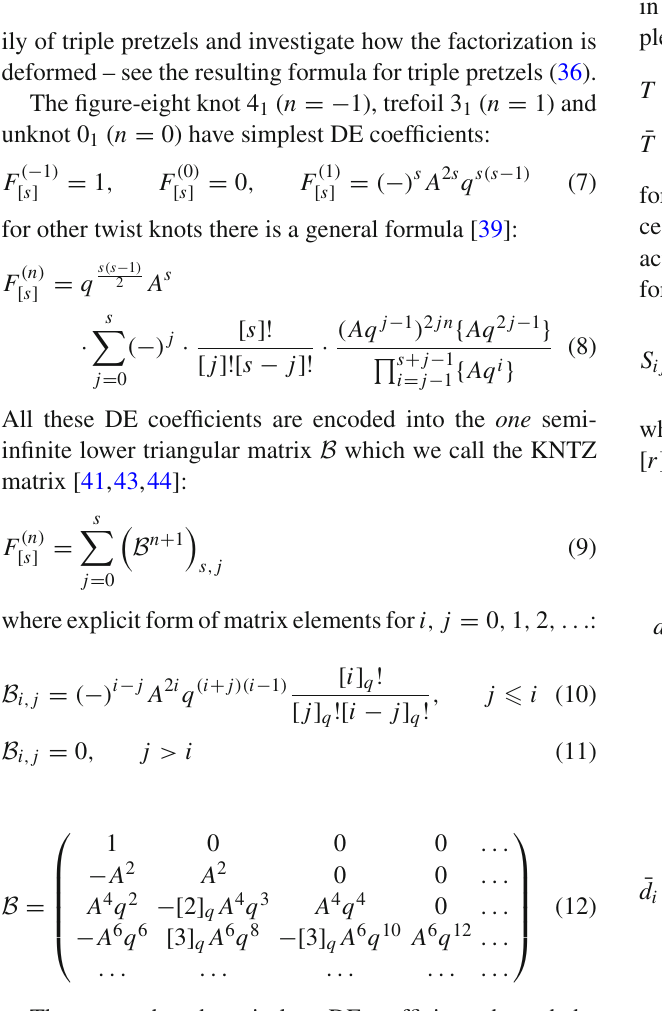
Fig. 2 The pretzel knot Pr ( 7 , 5 , 3 ) that is obtained after several steps of antiparallel evolution from the trefoil knot. Indeed, one can see that the crossings of the trefoil knot are replaced with 2-strand antiparallel braids of length 3, 5 and